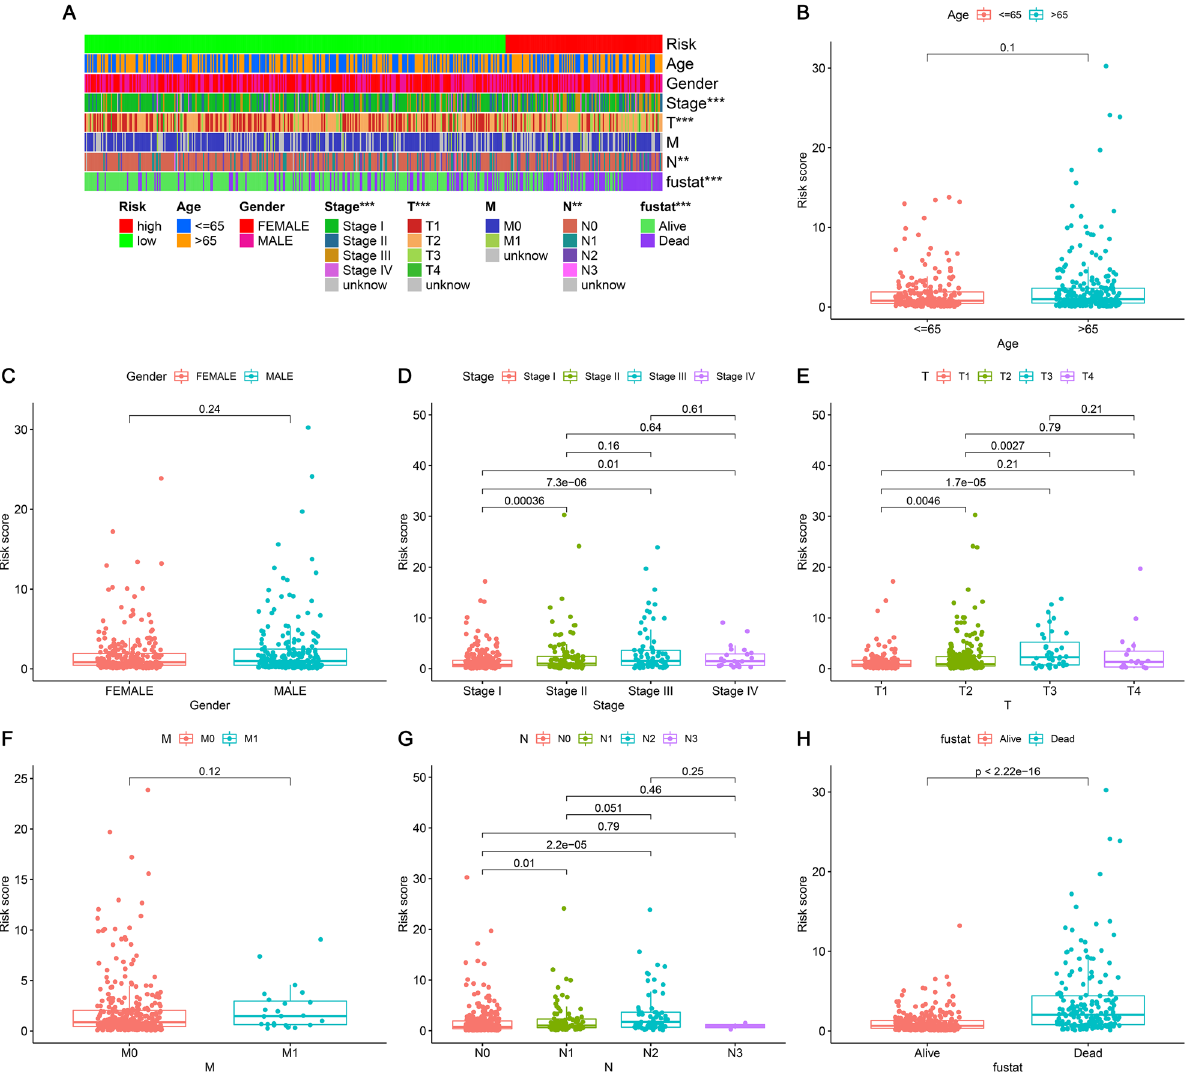
Figure 6. Risk coefficient model of LUAD for clinical correlation analysis. ( A ) The clinical correlation heatmap, ( B ) age, ( C ) gender, ( D ) clinical-stage, ( E ) T stage, ( F ) M stage, ( G ) N stage, and ( H ) survival